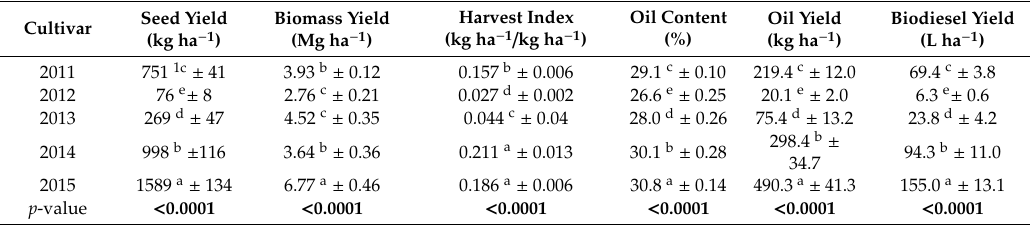
Table 4. Main e ff ect of year on seed yield (kg ha − 1 ), biomass yield (Mg ha − 1 ), harvest index (kg kg − 1